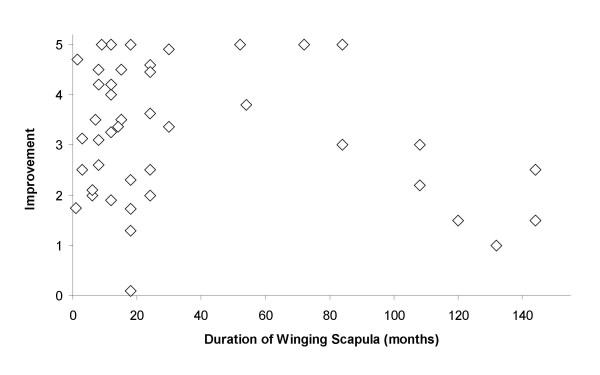
Quality of life improvement in 50 scapular winging instances.